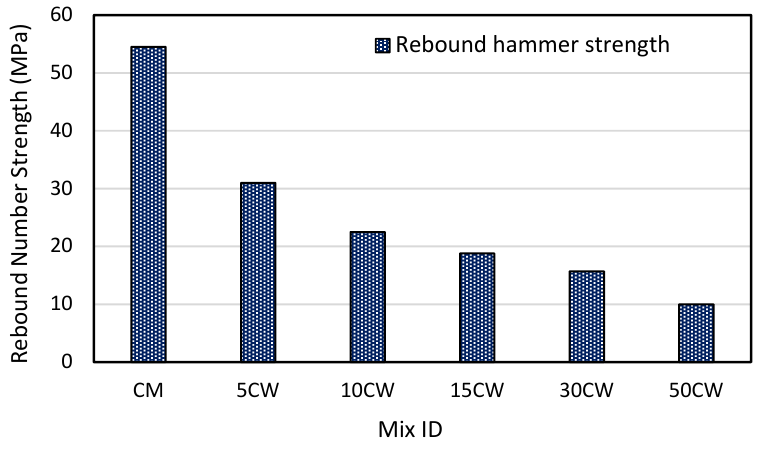
Figure 9. Rebound hammer strength for different mixes.